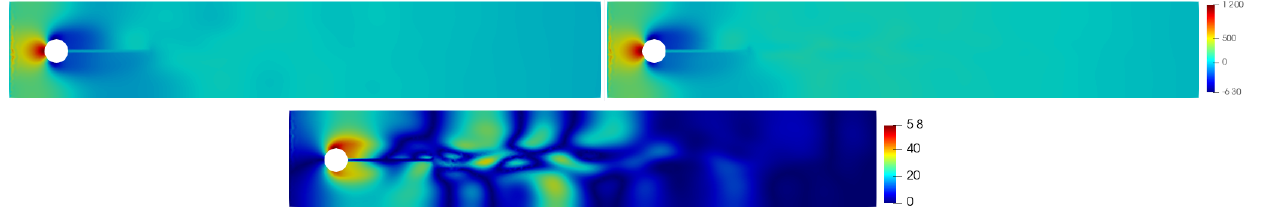
Figure 19. Pressure Poisson recovery: FE solution ( top left ), reduced order solution ( top right ), and local approximation error ( bottom ). The approximation was obtained with N p